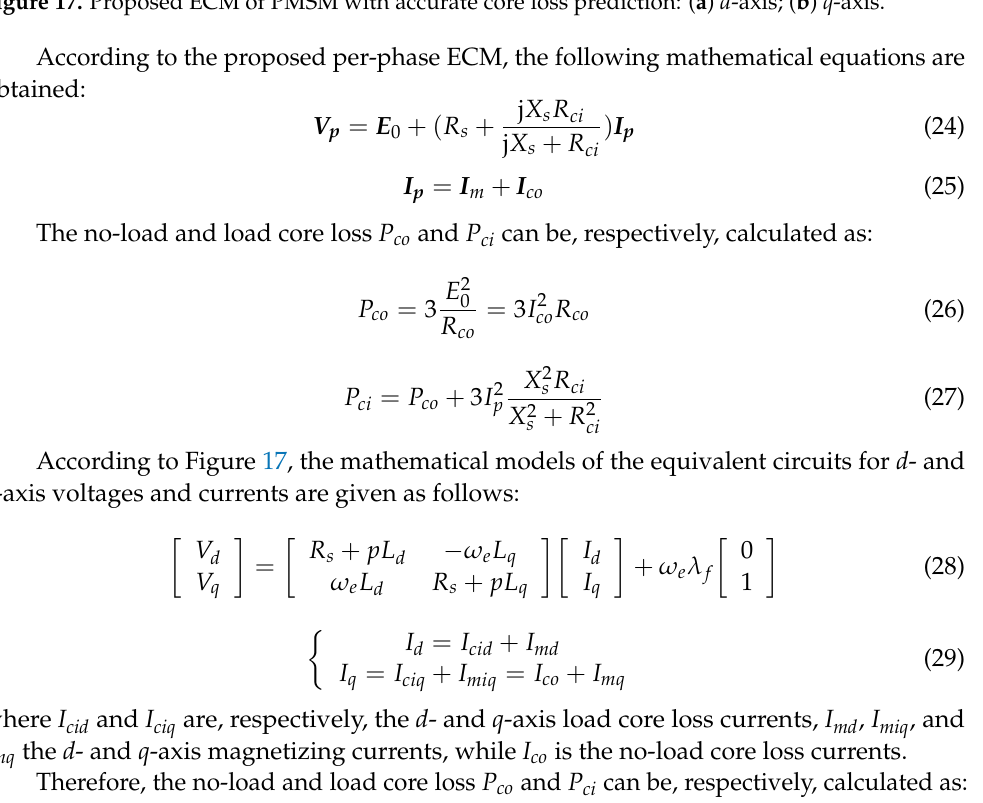
Figure 17. Proposed ECM of PMSM with accurate core loss prediction: ( a ) d -axis; ( b ) q -axis.